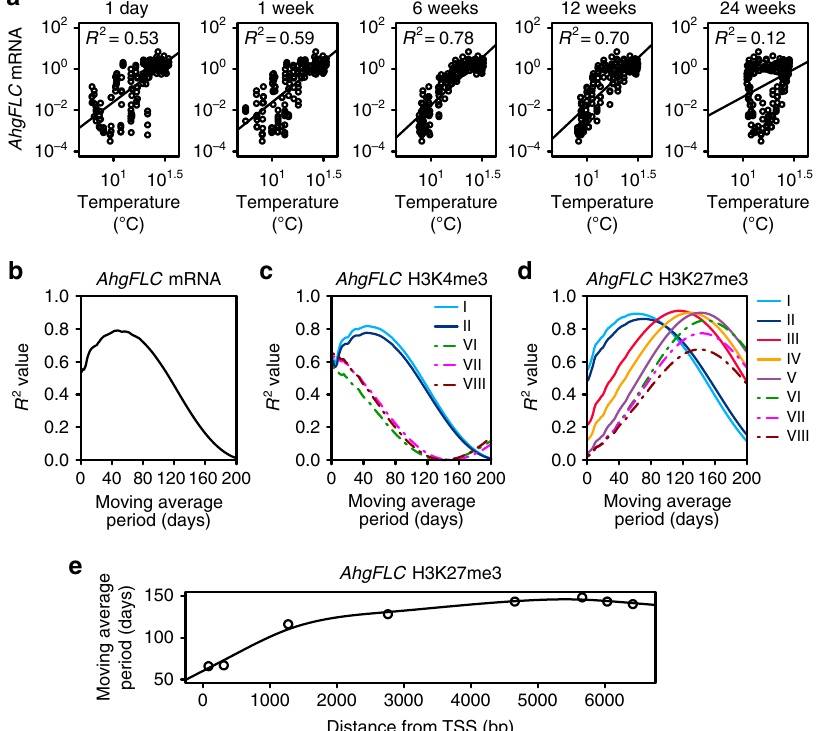
Fig. 2 Linear regression of AhgFLC mRNA and histone modi fi cation levels on the simple moving averages of past temperature. a AhgFLC mRNA levels were plotted against the simple moving averages (SMAs) of the daily mean temperature with window lengths of 1 day, and 1, 6, 12, and 24 weeks. A regression line and coef fi cient of determination ( R 2 ) are shown in each diagram. b – d The results of linear regression analyses on the SMAs of the daily mean temperature with different window lengths. R 2 values for AhgFLC mRNA ( b ), H3K4me3 ( c ) and H3K27me3 ( d ) levels are shown. Data are normalised against AhgACT2 (mRNA and H3K4me3) and AhgSTM (H3K27me3) before regression analyses. e Plotted along the AhgFLC locus are the moving average periods of temperature that showed the highest R 2 values for the H3K27me3 levels. Source data underlying Fig. 2a – d are provided as a Source Data fi